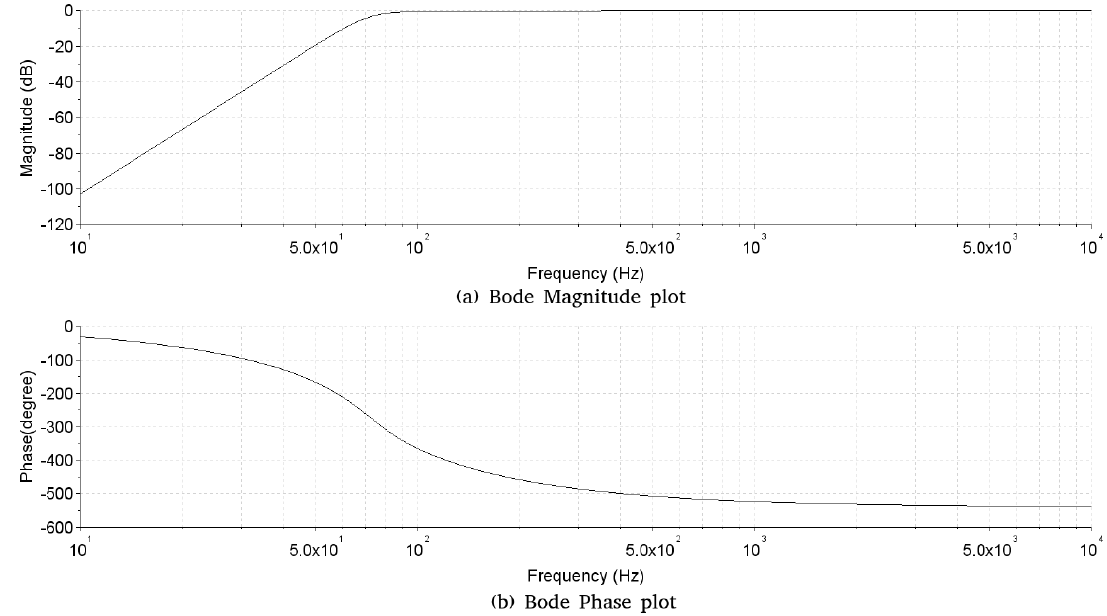
Figure 7. Bode diagram, with the Bode Magnitude plot ( a ) and the Bode Phase plot ( b ), of analog high-pass filter